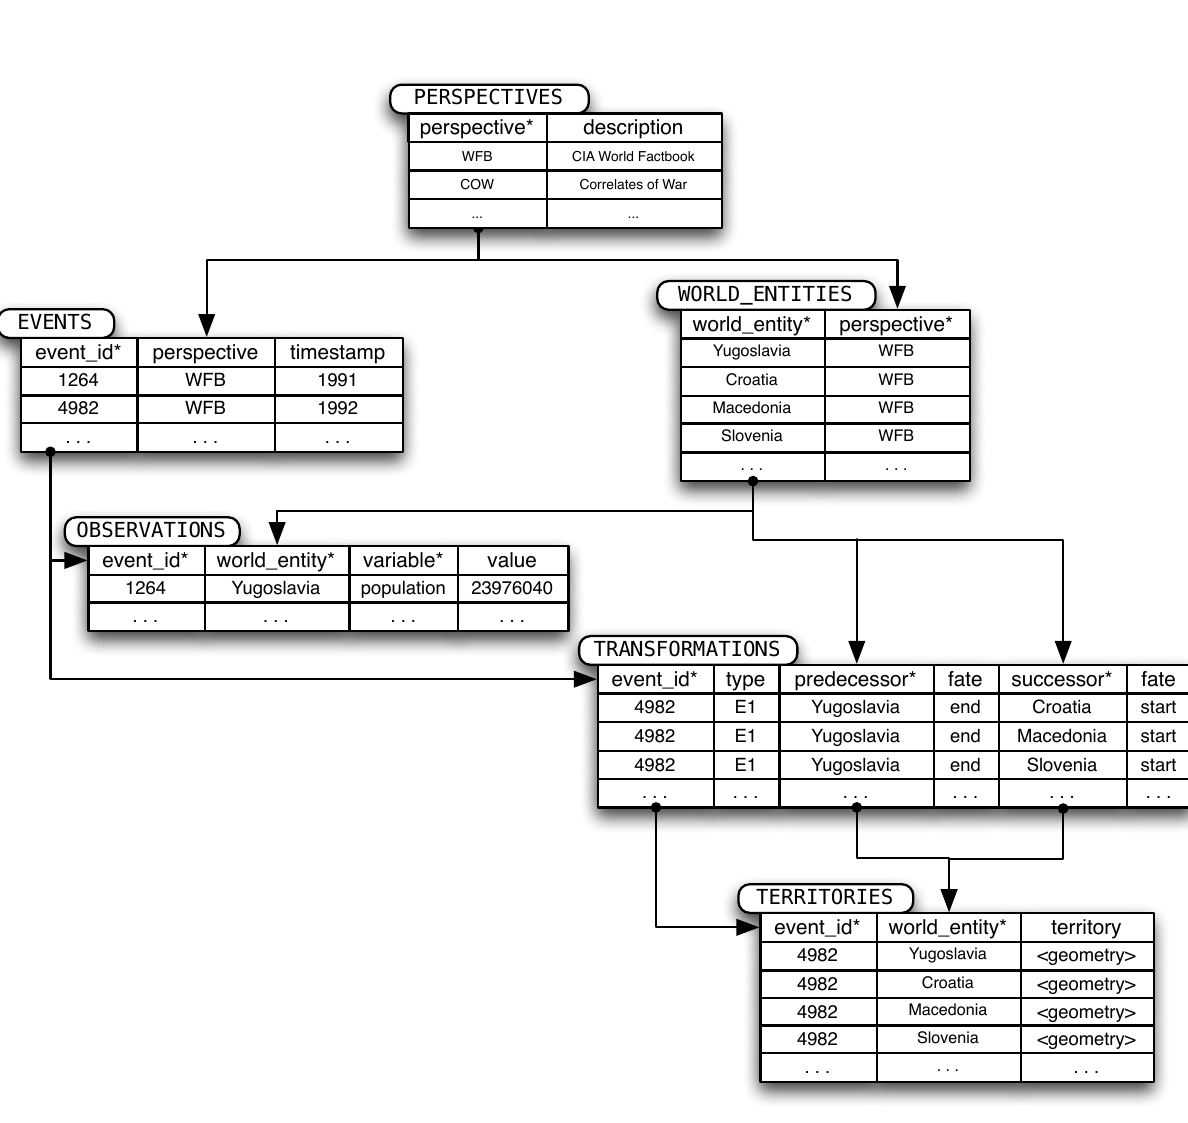
Figure 3. Database Schema (simplified)